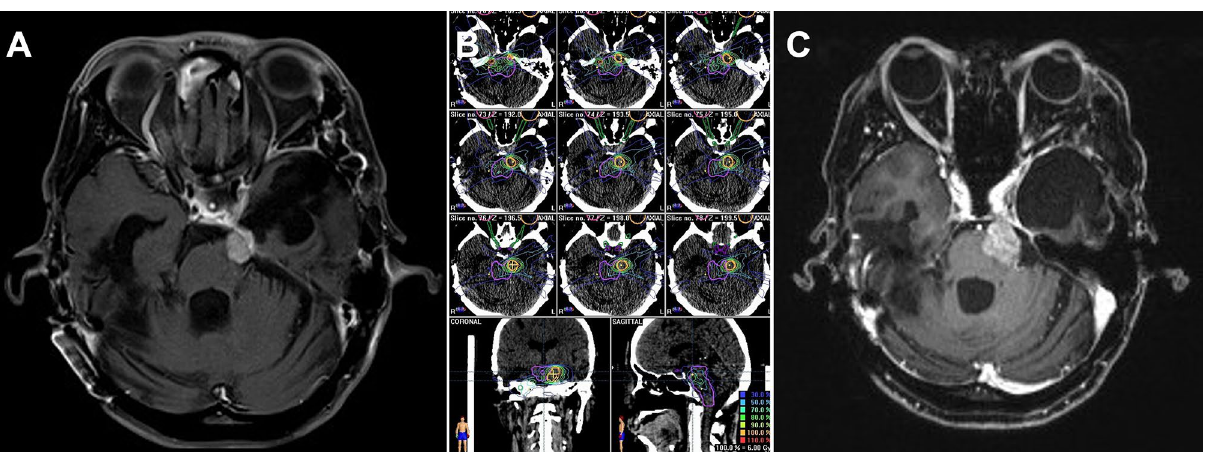
Figure 2. A 47-year-old female with a cerebellopontine angle meningioma (volume, 2.69 ml). Treatment was 21 Gy in three fractions. ( A ) Pre-treatment magnetic resonance imaging (MRI) scan. ( B ) Treatment plan showing the resulting isodose line. ( B ) MRI scan 98-months after treatment showing tumor